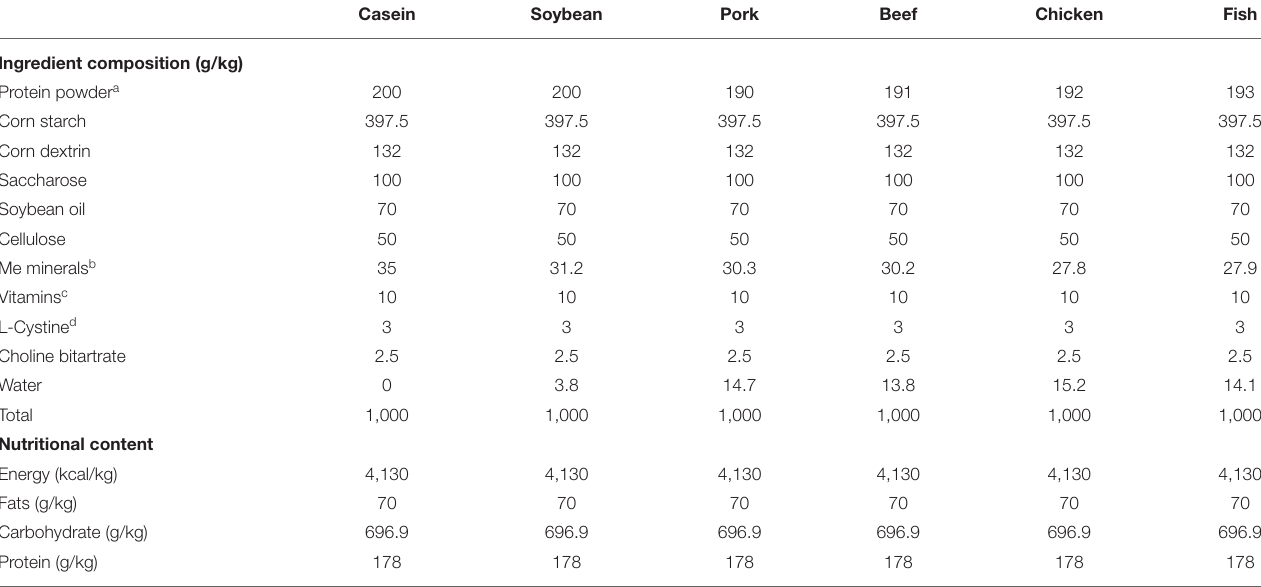
TABLE 1 | Composition and nutrients of the diets. Casein Soybean Pork Beef Chicken